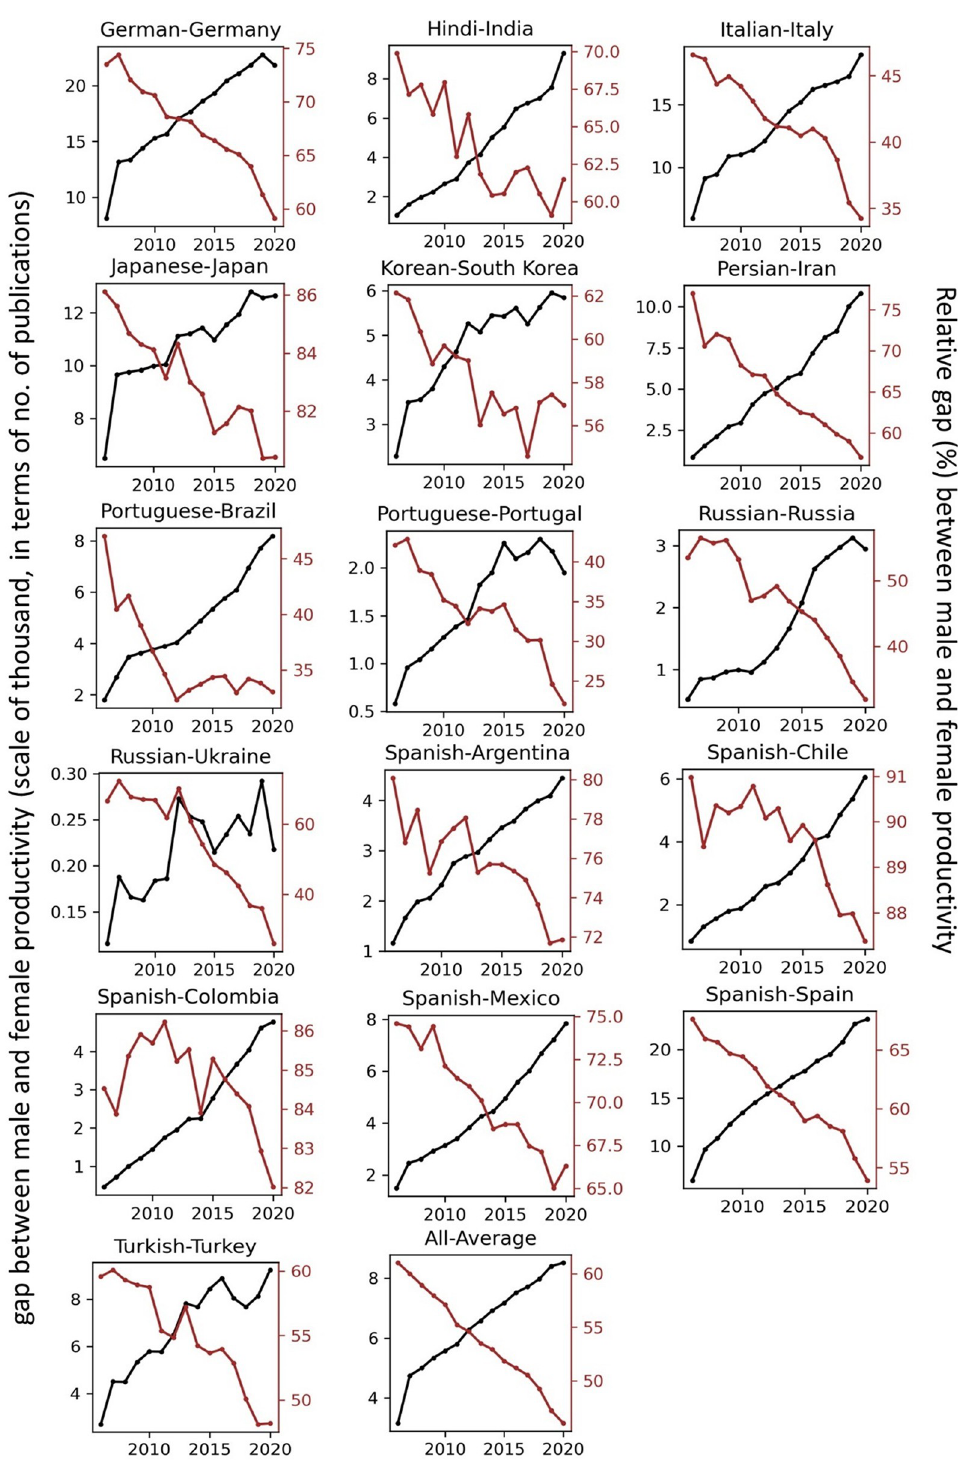
Fig 12. Gaps between male and female total research productivity, A-C method (part 2).